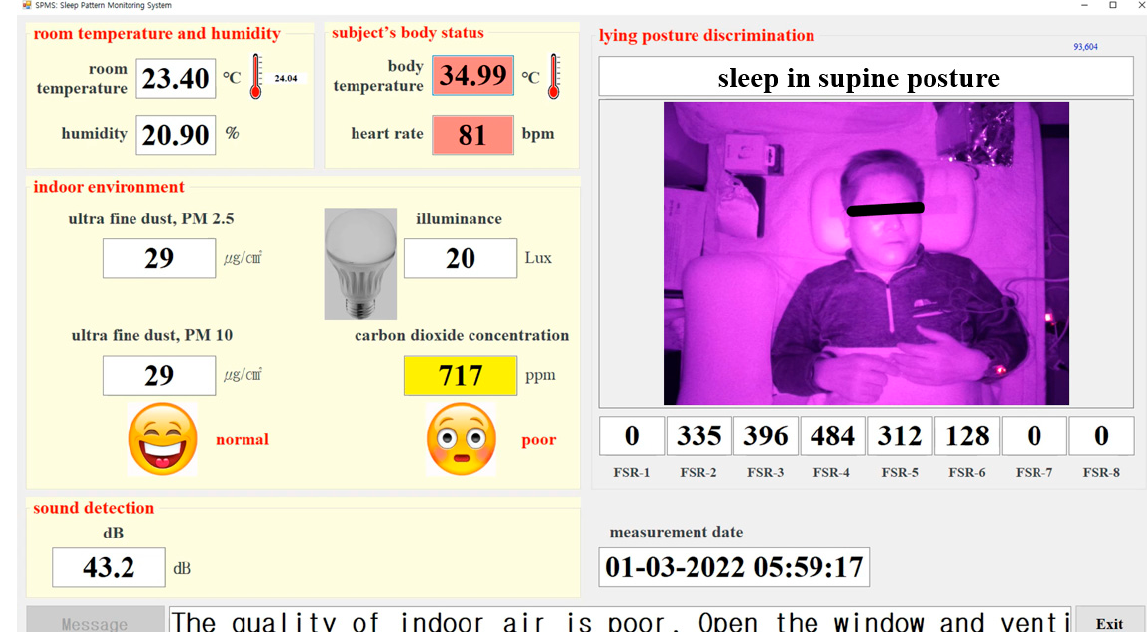
Figure 18. User interface screen of the sleep pattern monitoring system.